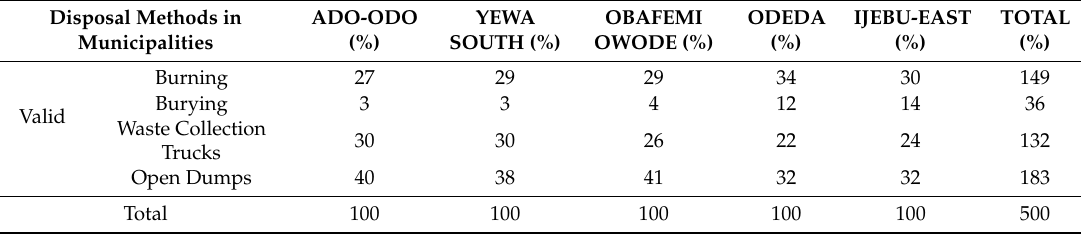
Table 5. Frequent disposal methods in municipalities.